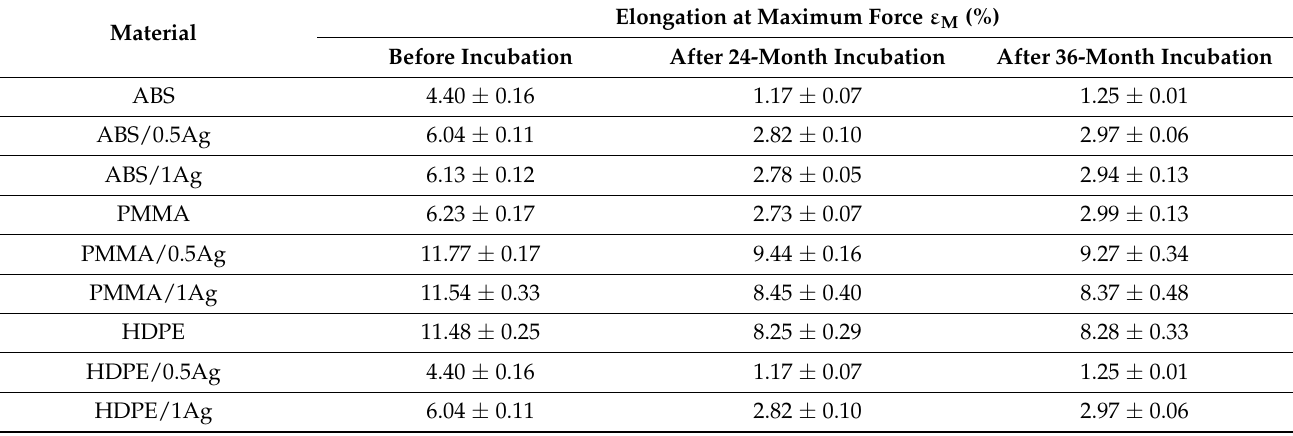
Table 5. Results of the elongation at maximum force of polymers and composites modified with 0.5 wt.% and 1.0 wt.%